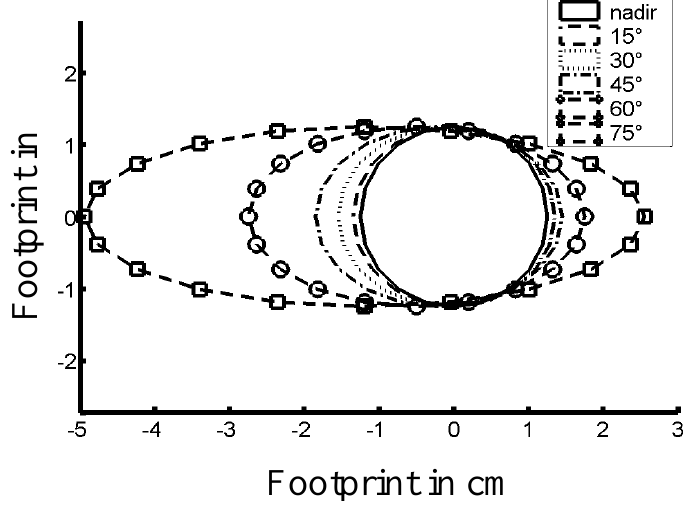
Figure 2 . The changing footprint area of the sensor’s field of view for various zenith angle positions. The dimensions are calculated for a 1° field-of-view and a distance of 0.35 m between the sensor and the